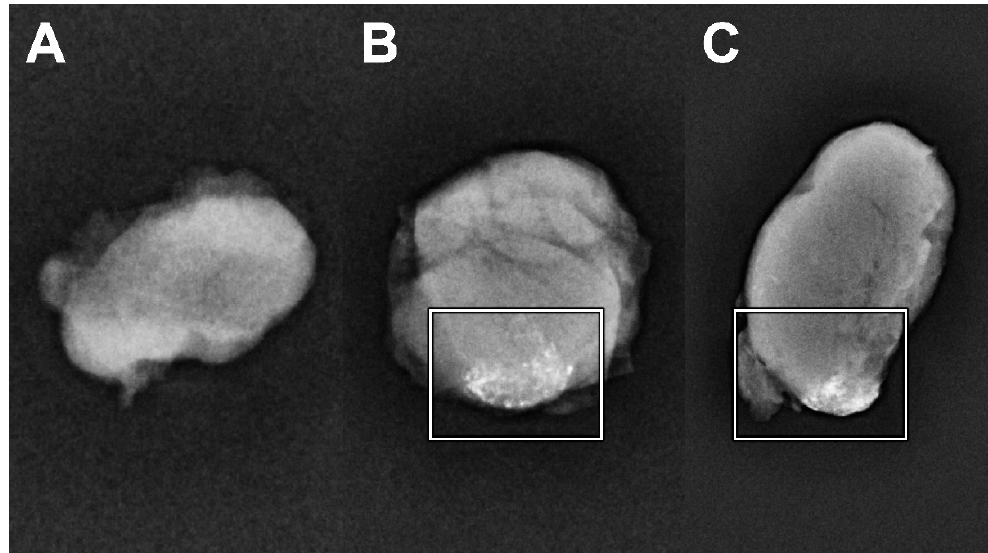
Figure 5. Low-dose X-ray of extirpated SLNs from patient 6. ( A ) SLN level Ib left (750 counts per second), which proved histopathologically positive for metastasis, showed no traces of Lipiodol ® . ( B , C ) SLN level Ib left (5387 counts per second; histopathologically negative) and SLN level IIa left (9194 counts per second; histopathologically positive) with the uptake of Lipiodol ® as confirmed by low-dose X-ray (white squares).